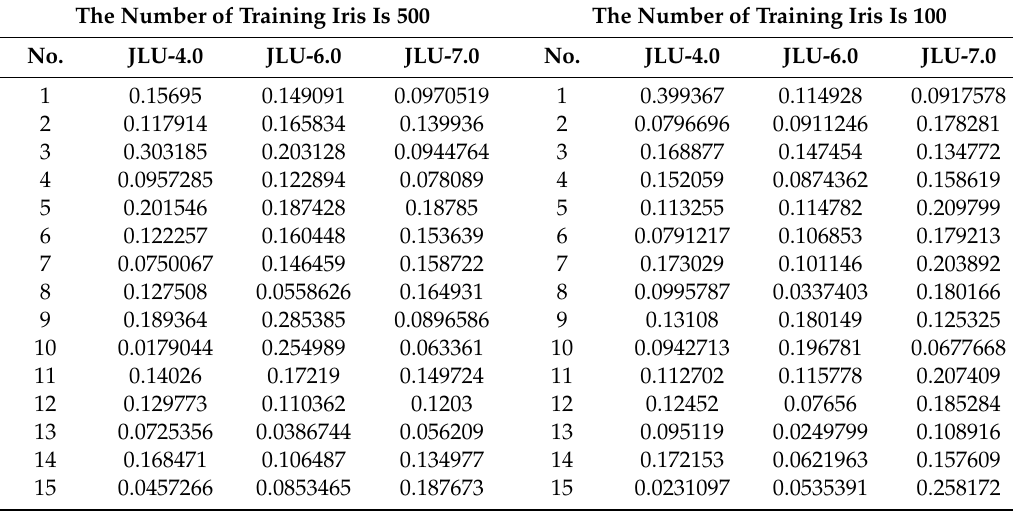
Table 11. The information o ff set Z i of the example training